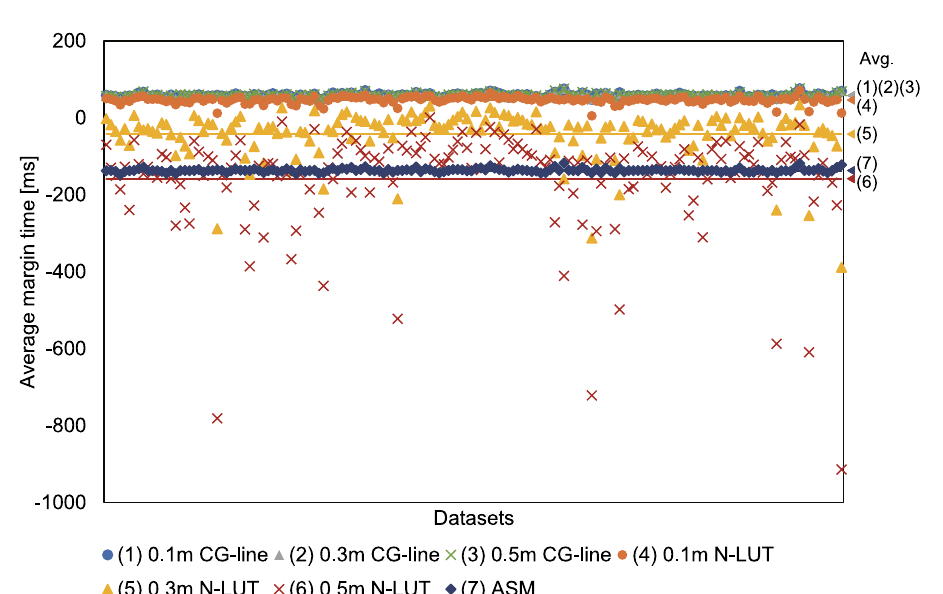
Figure 5. Results of the margin-time tests for different CGH calculations with each of the datasets.